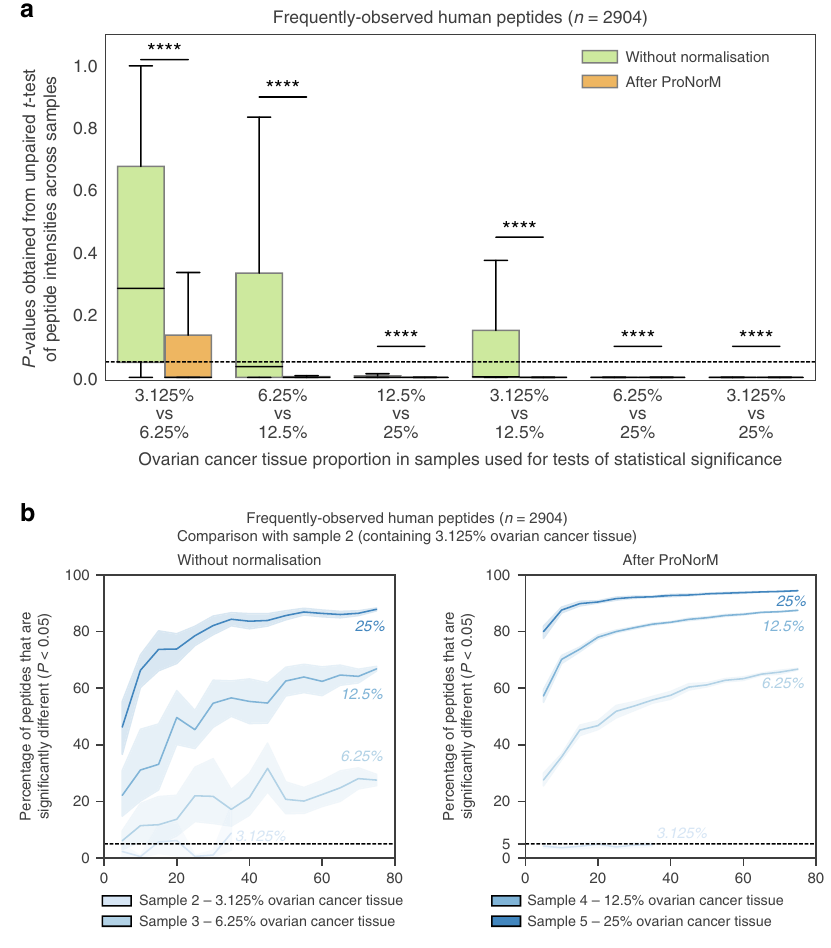
Fig. 5 Simulation of cohort analyses for discovery proteomics. a Distribution of p -values obtained from unpaired two-sided t -test of intensities of frequently observed human peptides ( n = 2904). Boxplots show p -values obtained when comparing samples containing the ovarian cancer tissue proportions indicated (ranging from 3.125% to 25%). Results are shown before normalisation (green) and after ProNorM (orange). The box indicates quartiles and the whiskers indicate the rest of the distribution, with outliers not shown. A black dashed line indicates a p -value of 0.05 and **** denotes P < 0.0001. b Percentage of frequently observed human peptides that were signi fi cantly different (vertical axis) in simulated cohorts of varying sizes (horizontal axis). Plots show comparison between Sample 2 (containing 3.125% ovarian cancer tissue) and Samples 2 – 5 (containing 3.125 – 25% ovarian cancer tissue), without normalisation (left) and after ProNorM (right). Shading denotes 95% con fi dence intervals derived from ten iterations of random selections of replicates of each sample. For statistical tests in both ( a , b ), the mean of each peptide was fi rst calculated within each set of assigned technical triplicates. Source data are provided as a Source data fi